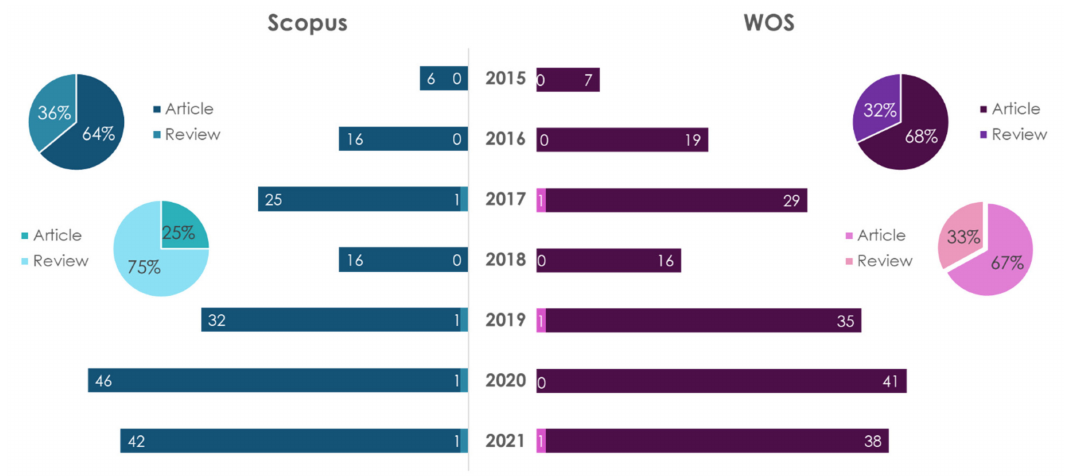
Figure 5. Statistical results of the search in Scopus/WOS databases by keywords “nutrigenetics” (dark color) and “nutrigenetics and atherosclerosis” (light color).